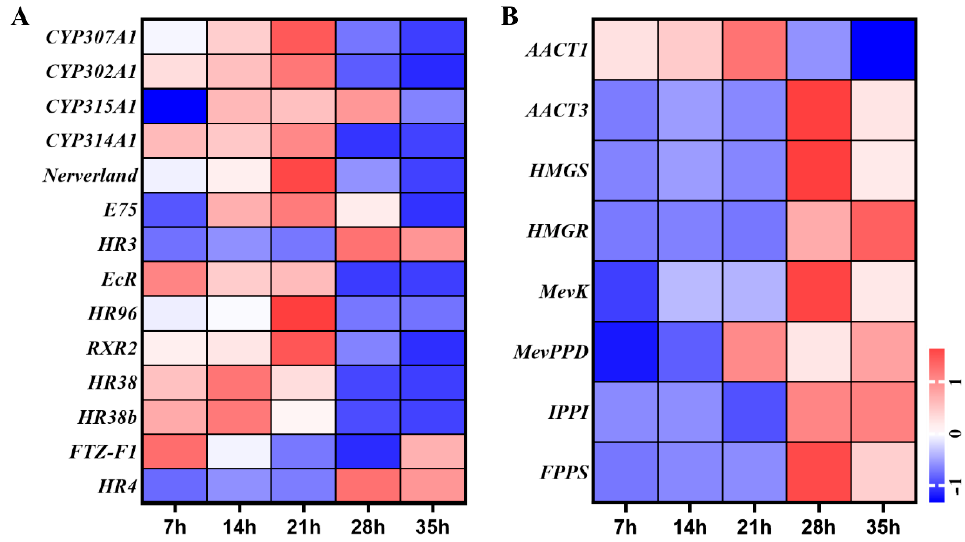
Figure 5. ( A ) Expression profiles of genes in ecdysteroids biosynthesis and signaling pathways of T. urticae . ( B ) Expression profiles of genes in juvenile hormone biosynthesis pathway of T. urticae . The color scales represent the values were normalized by Z-score ((value-mean value)/standard error) for each development time point.